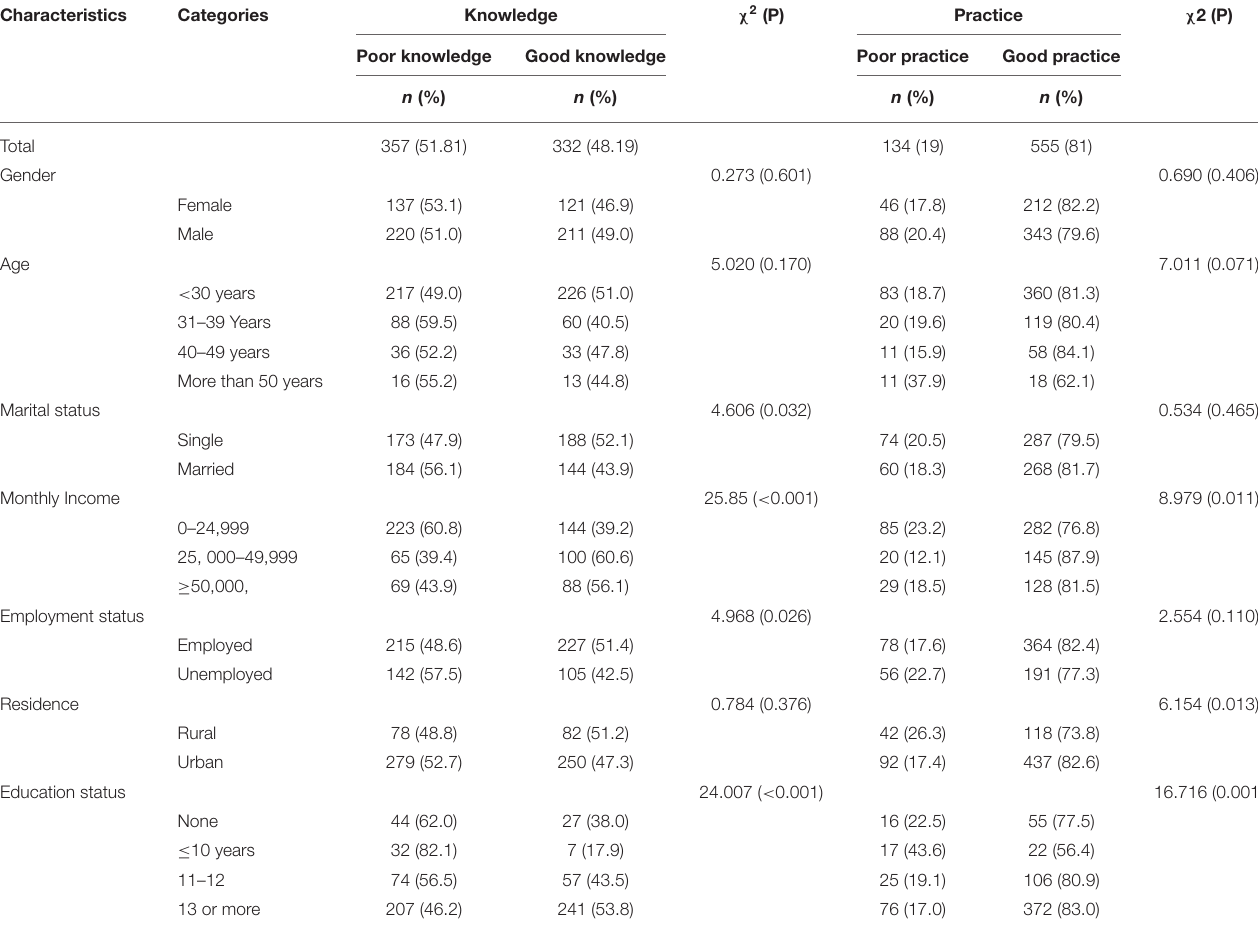
TABLE 2 | Difference in knowledge and practice status by